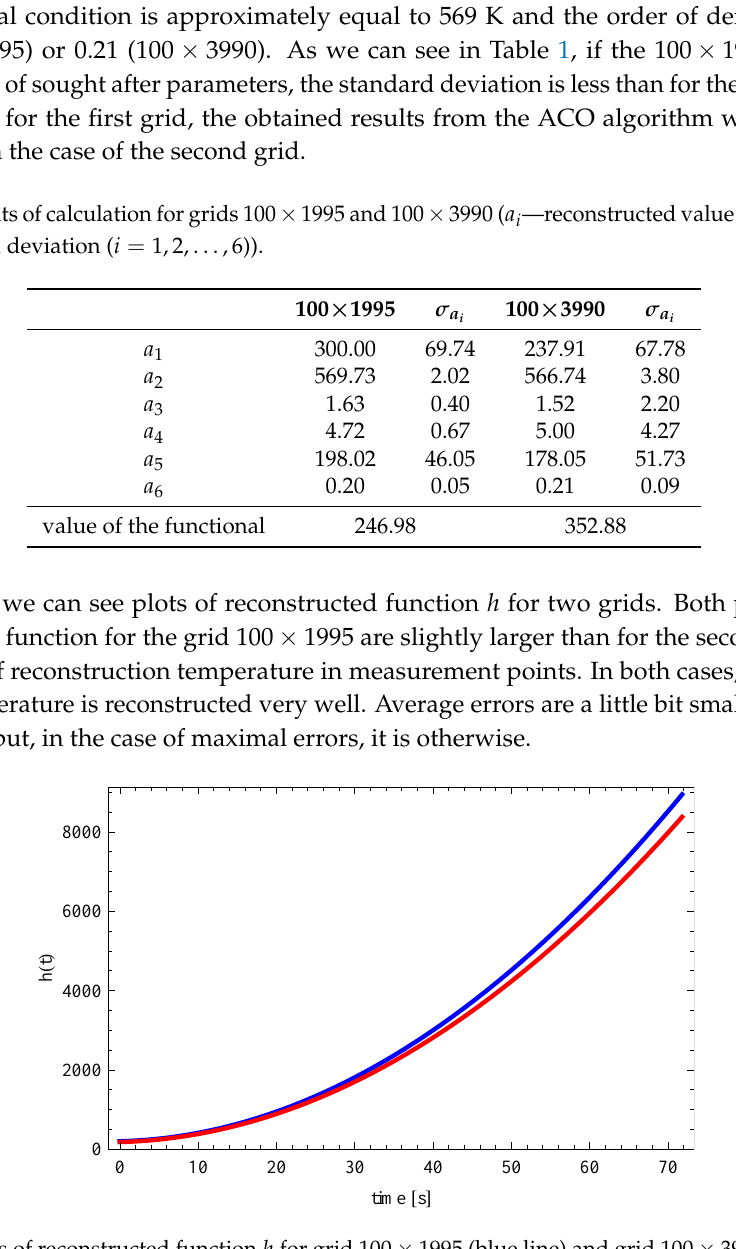
Figure 1. Plots of reconstructed function h for grid 100 × 1995 (blue line) and grid 100 × 3990 (red